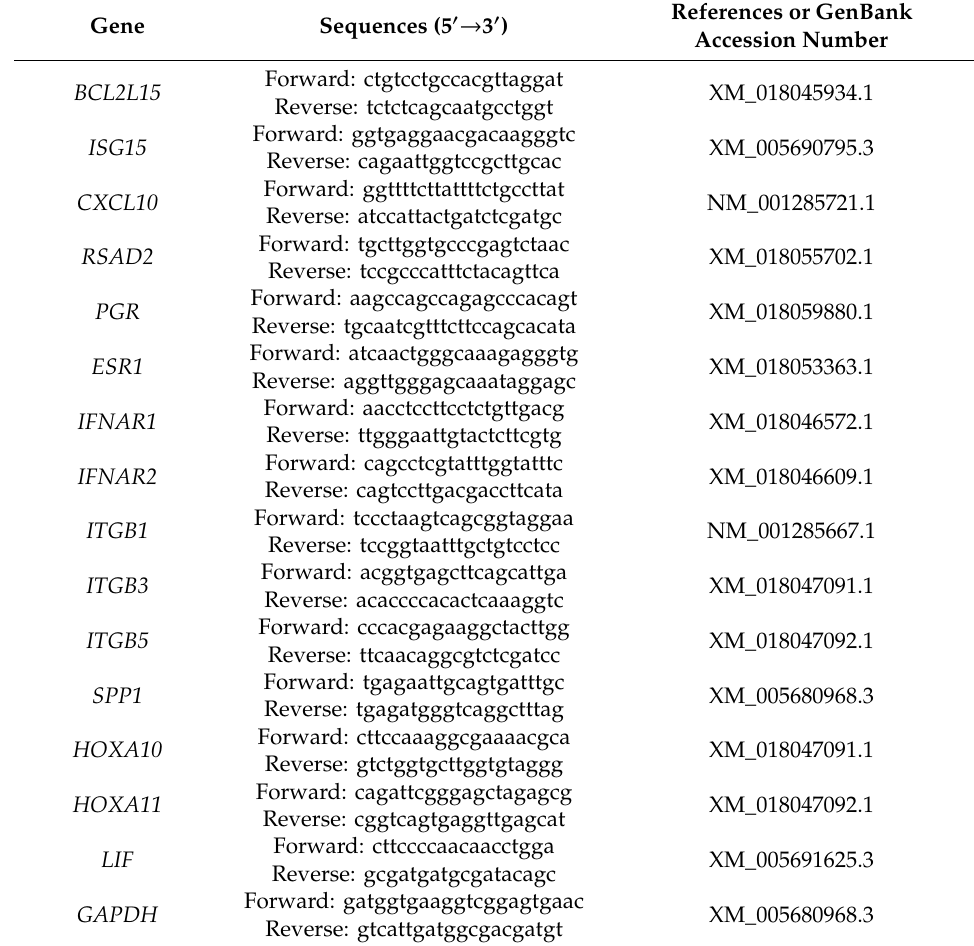
Table 2. Primer pairs used for real time quantitative